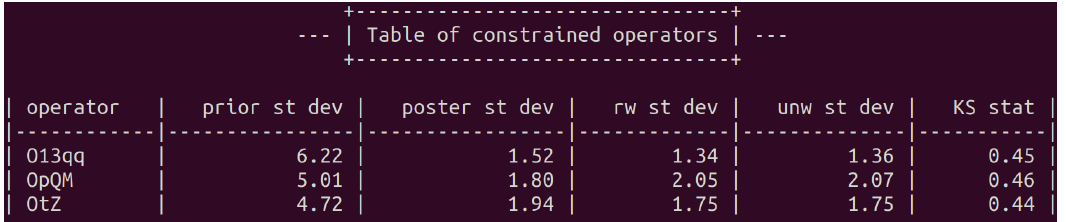
Figure A.2: A partial snapshot of the code output. The constrained SMEFT operators that satisfy the reweighting selection criteria of Sect. 3 are listed in a table with the value of their corresponding standard deviation and KS